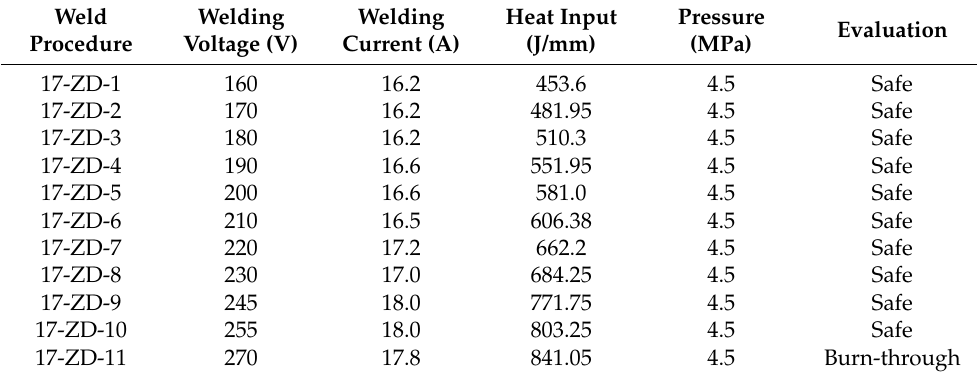
Table 5. Axial in-service welding observed with an external observation device.